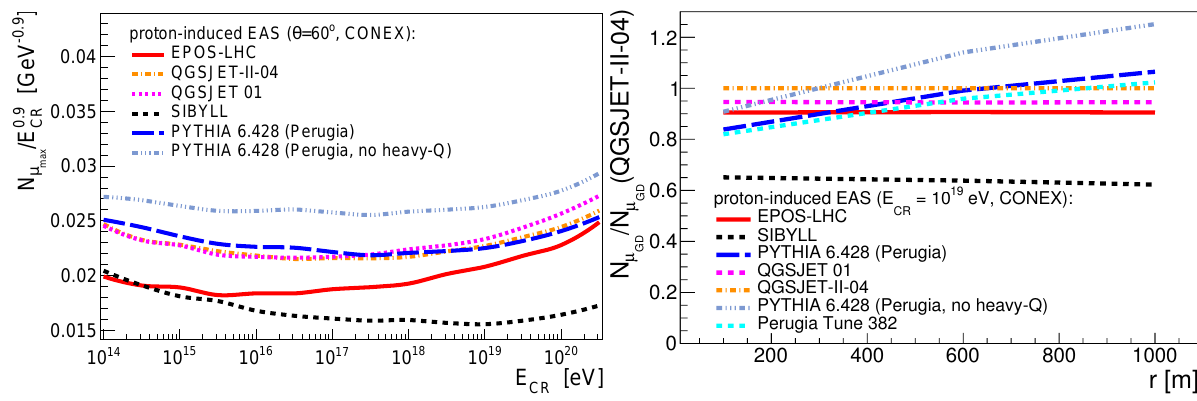
Figure 5. Left: Number of muons (normalized by E 0 . 9 ) at shower maximum for inclined proton-induced showers as a function of CR CR energy predicted by di ff erent MC generators [31]. Right: Number of muons at sea-level as a function of radial distance to the shower = 10 19 eV predicted by di ff erent MC generators over the qgsjet - ii -04 value axis for proton-induced EAS of E CR